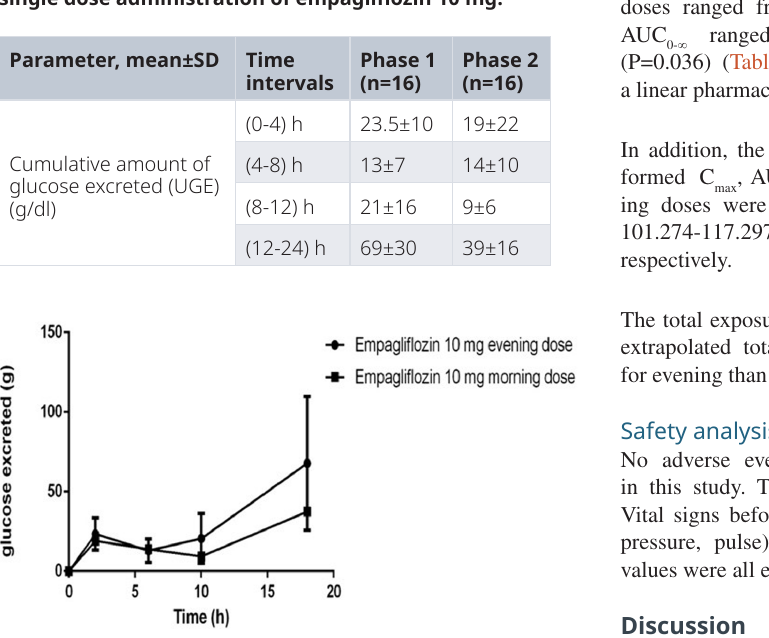
Figure 2. Cumulative amount of glucose excreted for the evening (phase 1) and morning (phase 2) after administration of empagliflozin 10 mg.